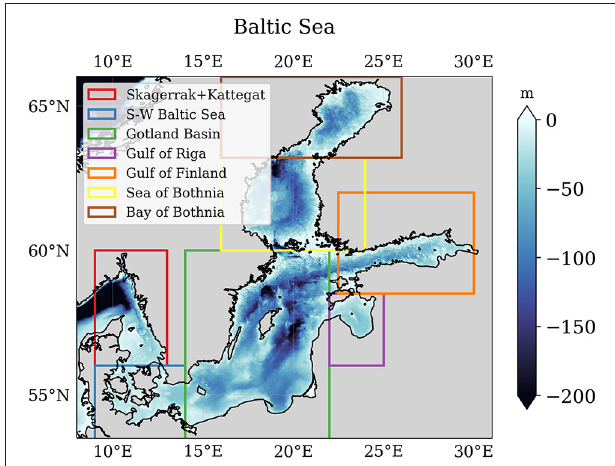
FIGURE 2 | The area of study divided in different boxes representing major sub-basins. Color shades display the